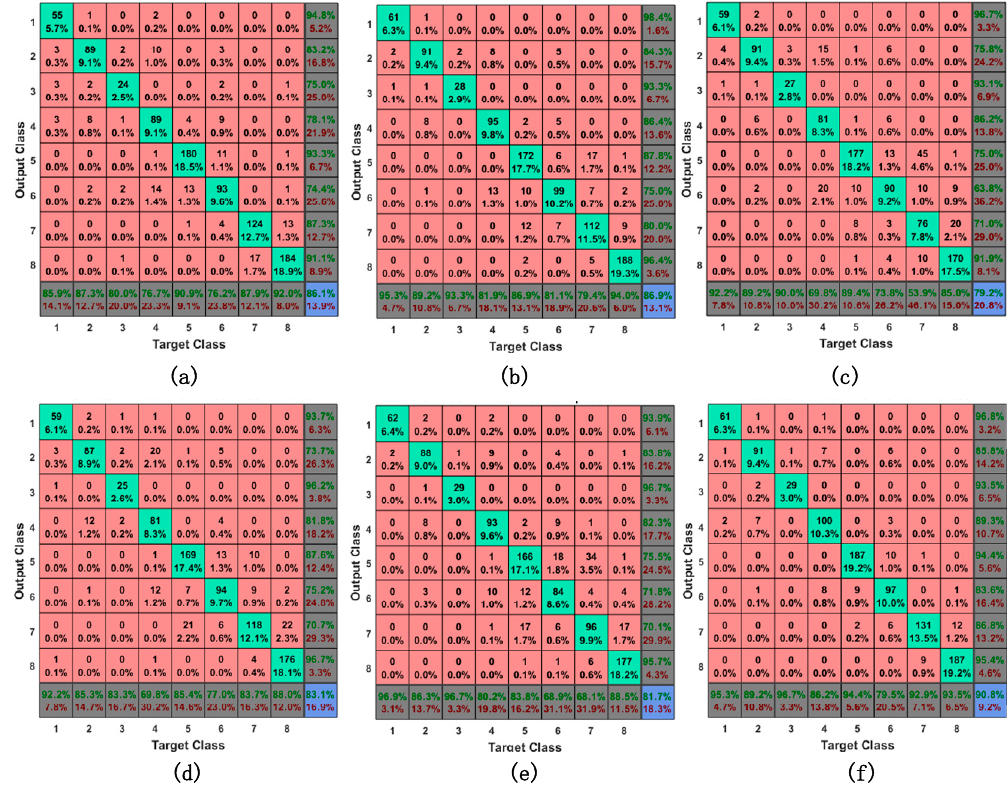
Figure 6. Confusion matrix comparison of six classifiers, including the results of ( a ) Fine Tree; ( b ) Radial basis function kernel support vector machine; ( c ) Weighted K-Nearest Neighbors (KNN); ( d ) Linear Discriminant Analysis; ( e ) Subspace KNN and ( f ) Random Forest. The labels in each subfigure